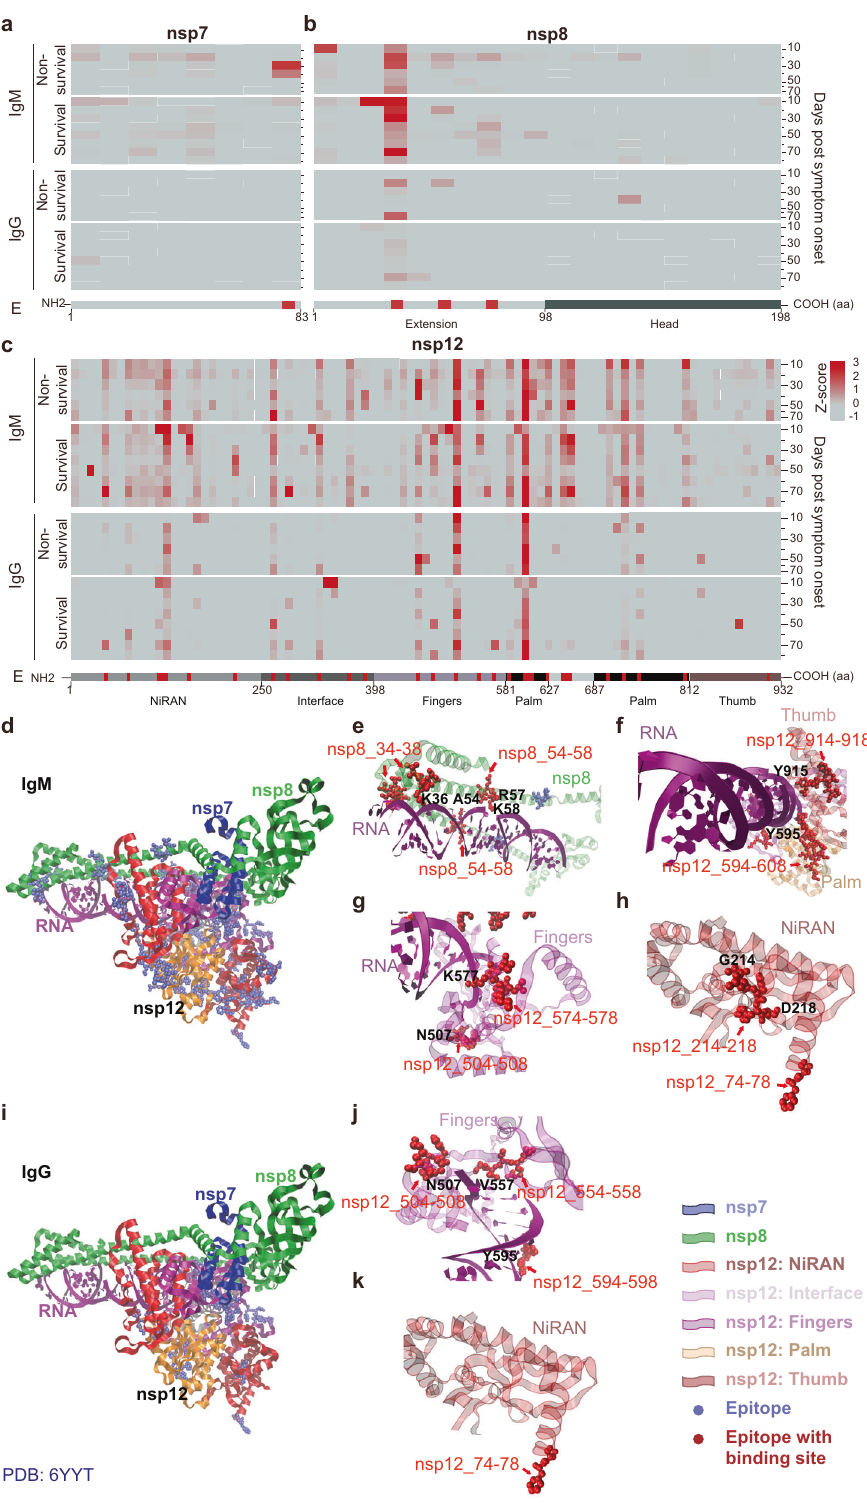
Fig. 5 Dynamic changes of antibody epitopes within the SARS-CoV-2 RNA-dependent RNA polymerase (RdRp). a – c Longitudinal changes of IgM and IgG antibody epitopes identi fi ed within the SARS-CoV-2 nsp7, 8, and 12 proteins, respectively. d – h Structural analyses of IgM epitopes on the RdRp complex, nsp8-RNA interaction interface, Thumb and Palm domain, Fingers domain, and N-terminal nidovirus RdRp-associated nucleotidyltransferase (NiRAN) domain, respectively. i – k Structural analyses of IgG epitopes on the RdRp complex, nsp8-RNA interaction interface, Fingers domain and NiRAN domain, respectively. The epitopes within the functional domain that may interfere the protein activity are labeled in